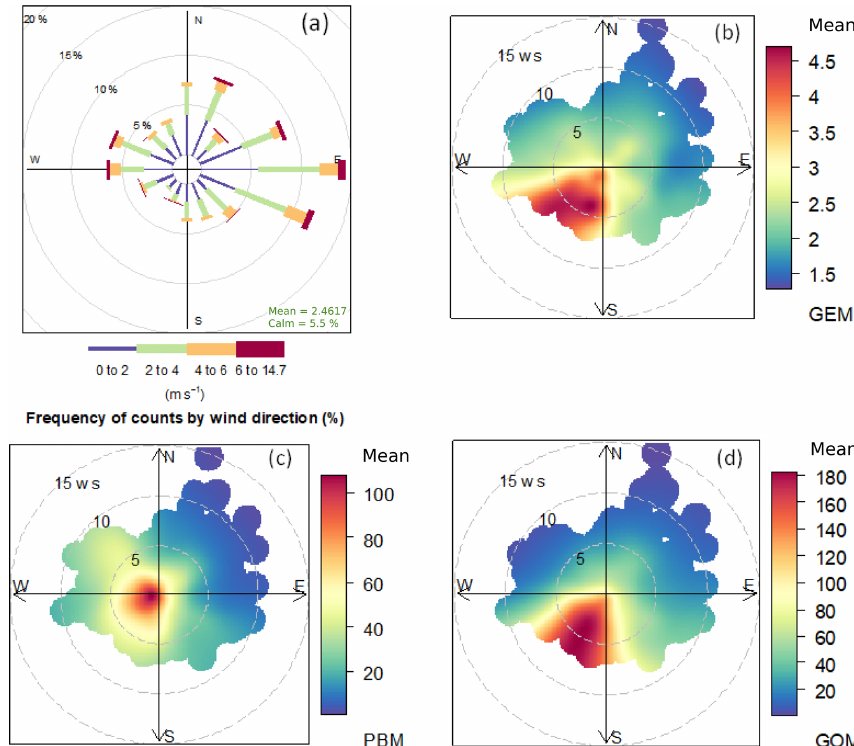
Figure 5. (a) Wind rose plot during the study period. Mean concentrations of (b) GEM, (c) PBM, and (d) GOM as a function of wind speed and wind directions. The radii of the circle in (a) represent the frequency of wind directions and the radii of the circle in (b–d) represent the value of wind